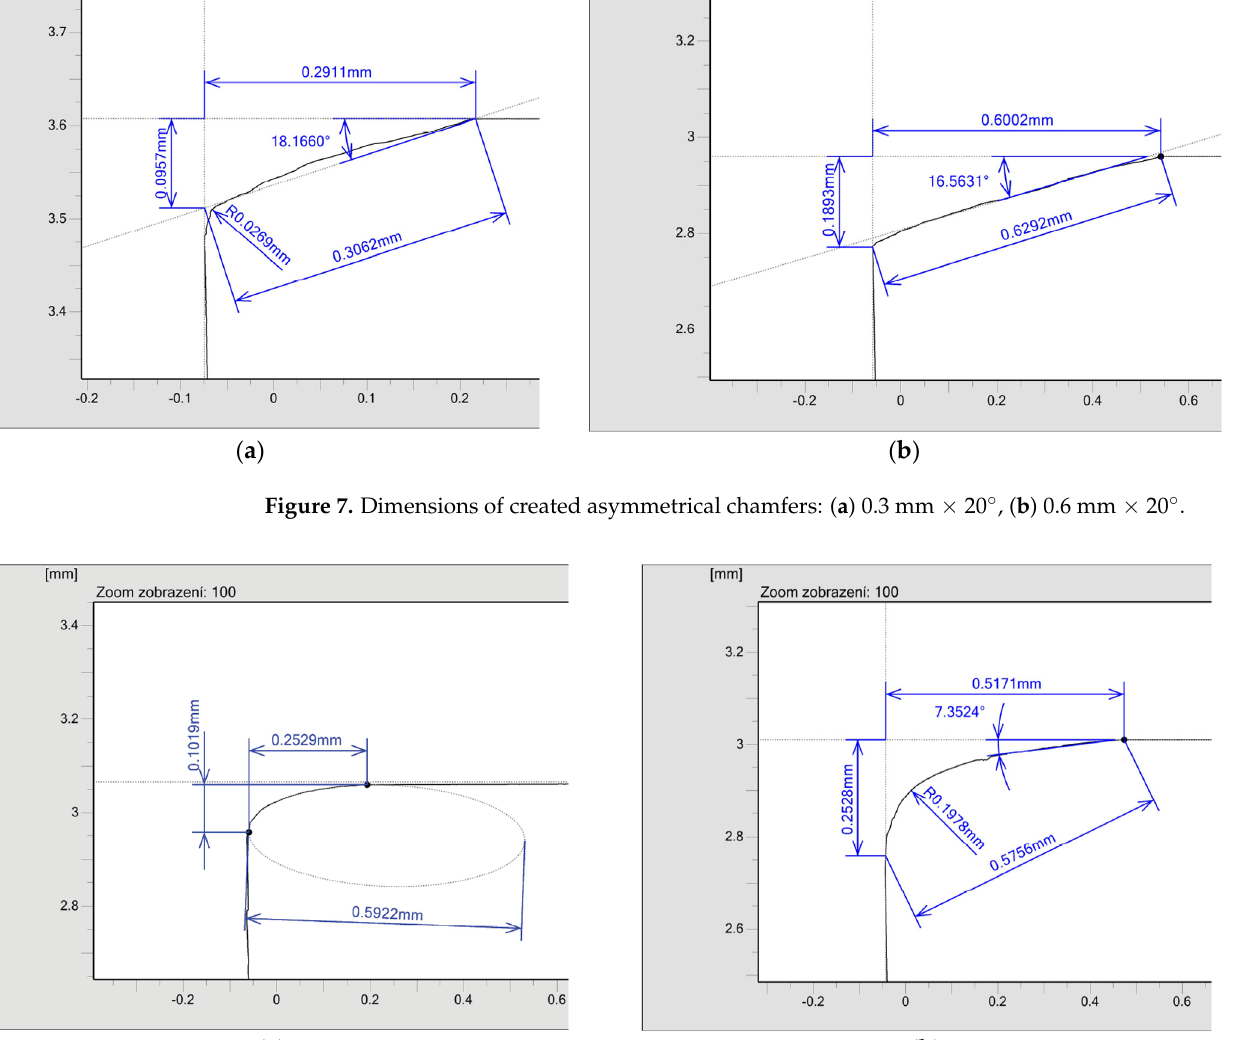
Figure 8. Dimensions of the created elliptical fillets: ( a ) 0.25 × 0.1 mm, ( b ) 0.5 × 0.2 mm.